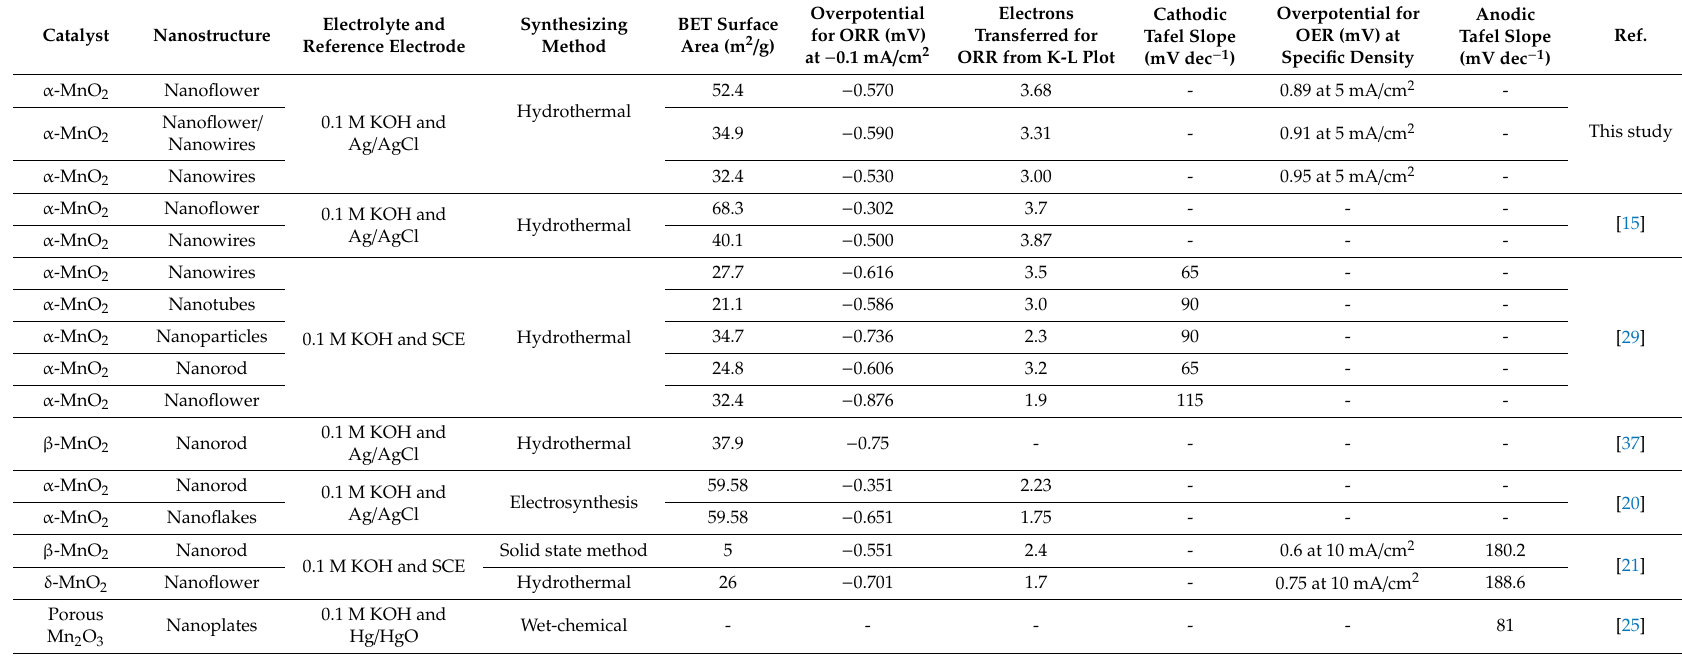
Table 2. Summary of the ORR and OER parameters of recently reported nanostructure manganese oxide